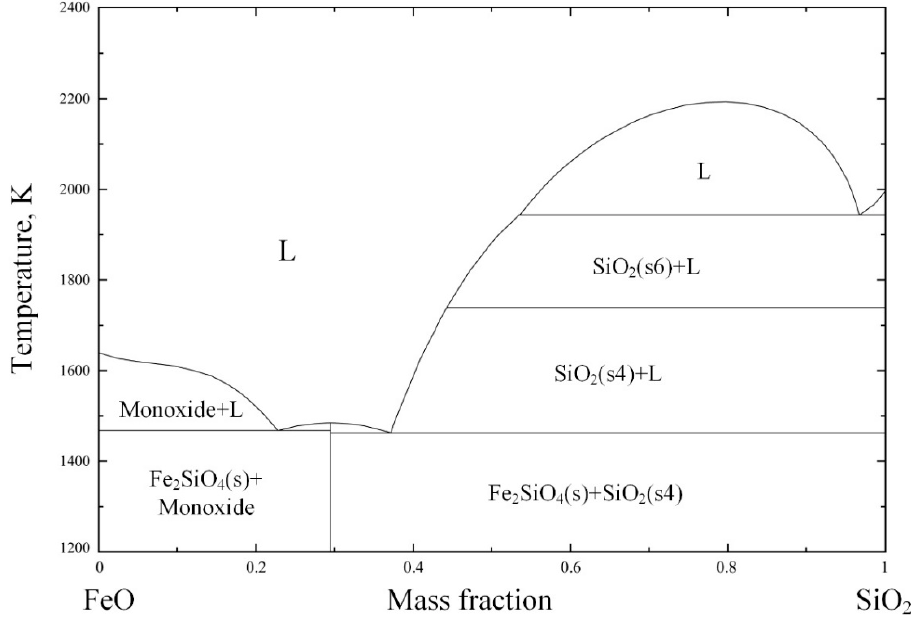
Figure 5. FeO–SiO 2 phase diagram for p = 1 atm, drawn with FactSage 7.2.